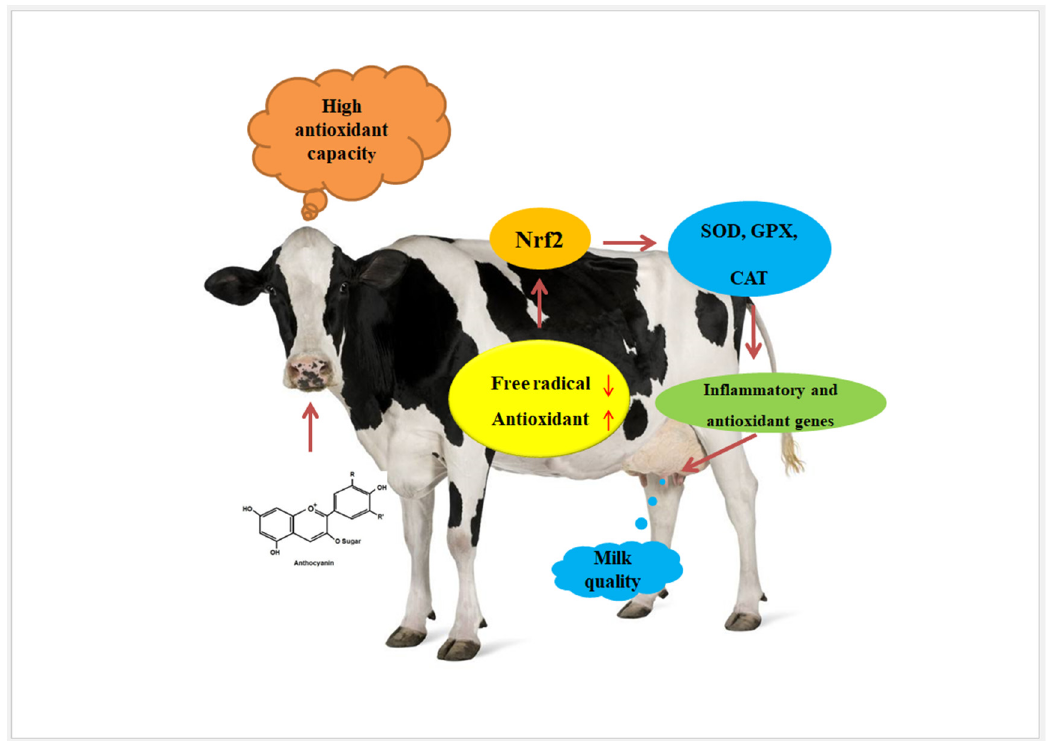
Figure 3. The postulated mechanism by which anthocyanins improve health in dairy cows.